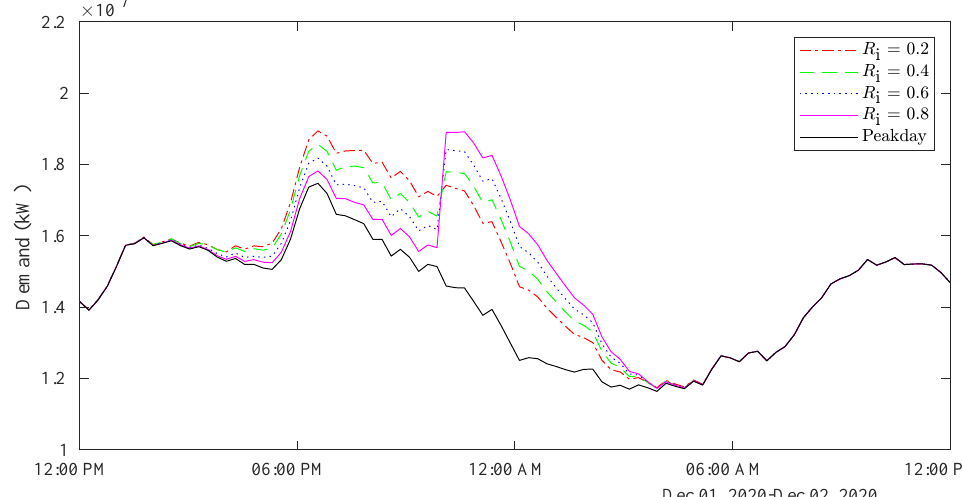
Figure 13. Load demand of the PEA under different levels of R i when the TOU pricing policy is applied with T b = 10:00 p.m., 20% penetration, and uniform distribution of S i . The last simulation is about the variation of T b . Each variation of T b results in the changing of the TOU tariff policy where T b varies from 9.00 p.m. to 12.00 a.m. where the R i is 0.5, and the EV penetration level is 20% on the uniform distribution of S i . The simulation results in Figure 14 show that when the T b is shifting, the second peak of load demands is shifting and decreasing. The maximum peak load demand of the electrical distribution system increases by 8.4%, 5.6%, 5.5%, and 5.5% when the T b are 9:00 p.m., 10:00 p.m., 11:00 p.m., and 12.00 a.m., respectively. We can see that for T b = 9:00 p.m., the maximum peak occurs at 9:00, while for T b = 10:00 p.m., 11:00 p.m., and 12:00 a.m., the maximum peak occurs at 6:45 p.m.